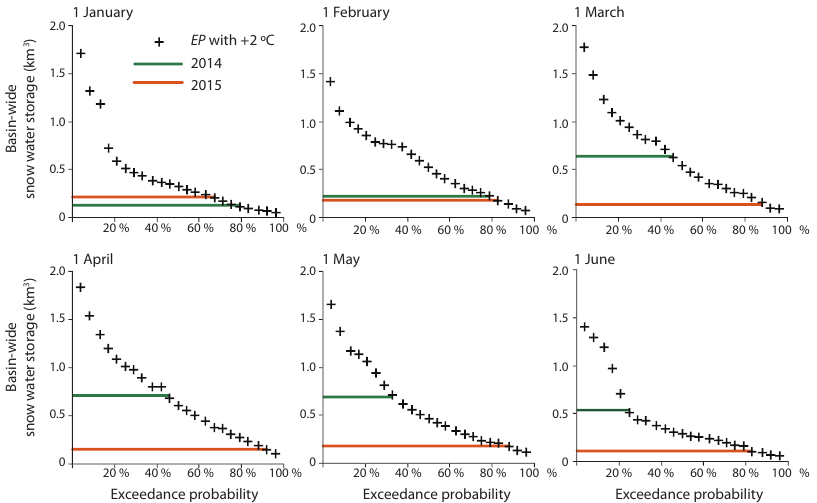
Figure 3. The exceedance probability of basin-wide snow water storage under + 2 ◦ C conditions. During 2014, snow water storage increased considerably in March to reach above-average conditions. The snowpack during the winter of 2015 was extremely low and never increased beyond 0.21km 3 . The calculations are 5-day averages centered on the first day of each month.